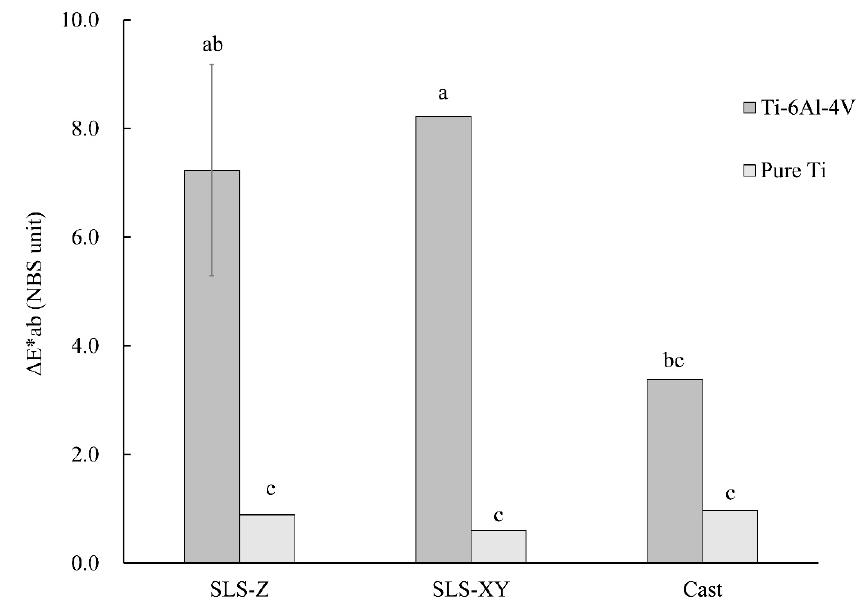
Figure 6. Color di ff erence with lactic acid solution. The same lowercase letter indicates a combination Figure 6. Color difference with lactic acid solution. The same lowercase letter indicates a with no significant di ff erence ( p > 0.05). Error bar represents 95% confidence interval. combination with no significant difference ( p > 0.05). Error bar represents 95% confidence interval.